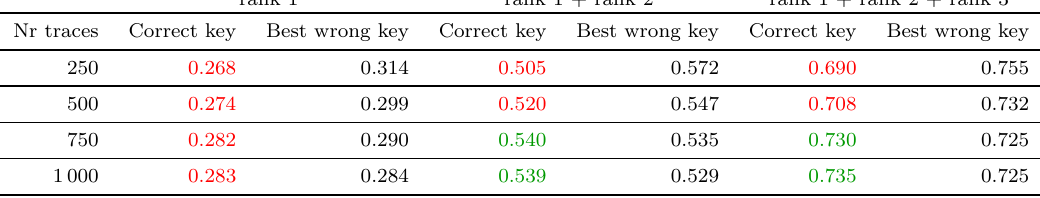
Table 5: Density for class probability ranks 1, 2, and 3 for the ASCAD dataset in the Hamming weight